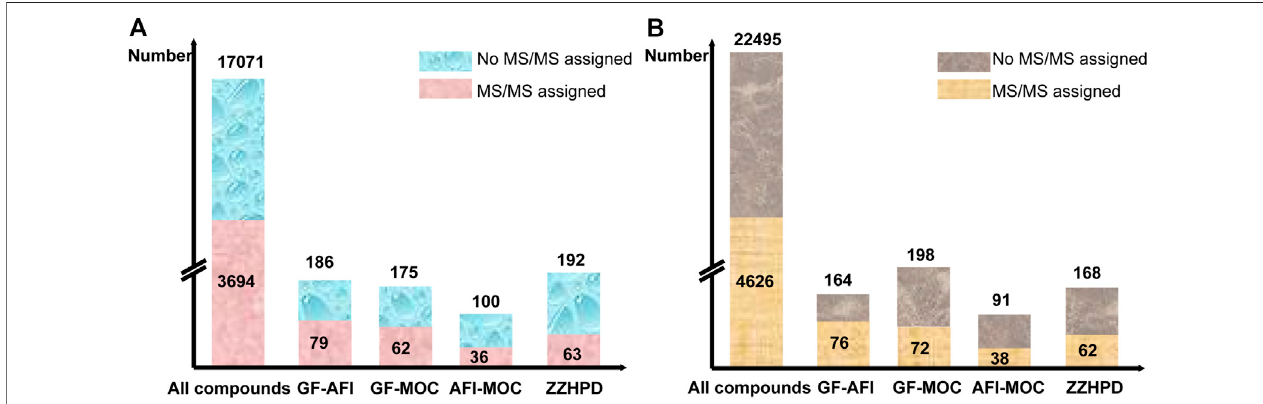
FIGURE 3 | Data processing results of MSdial software in the positive mode( A ) and in the negative mode( B